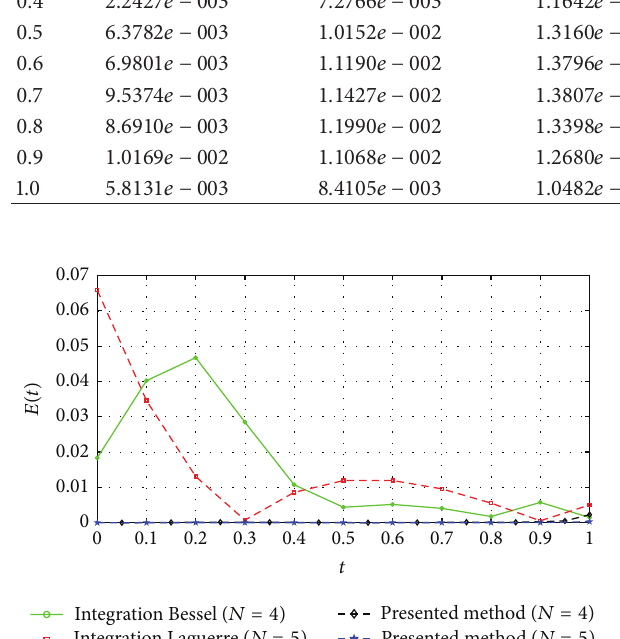
Figure 1: The error histories of our method together with the methods [11, 32] in Example